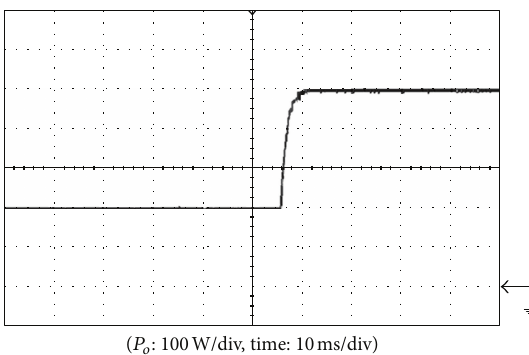
Figure 28: Output power variation while wind turbine incorporates into the hybrid generation system.